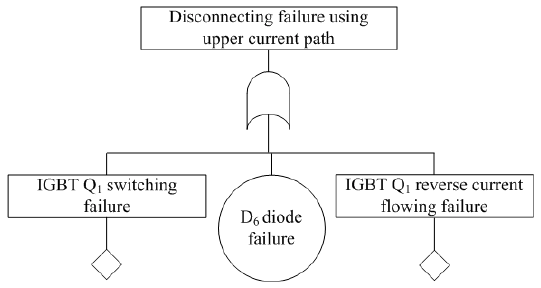
Figure 14. Sub fault tree for disconnecting failure using upper current path.